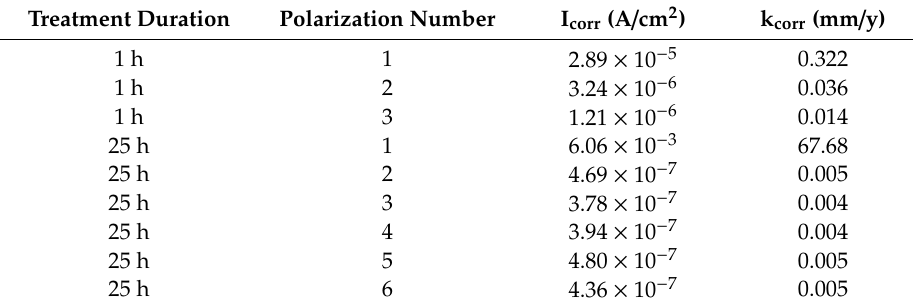
Table 3. Tafel analysis of Monel coated graphene.